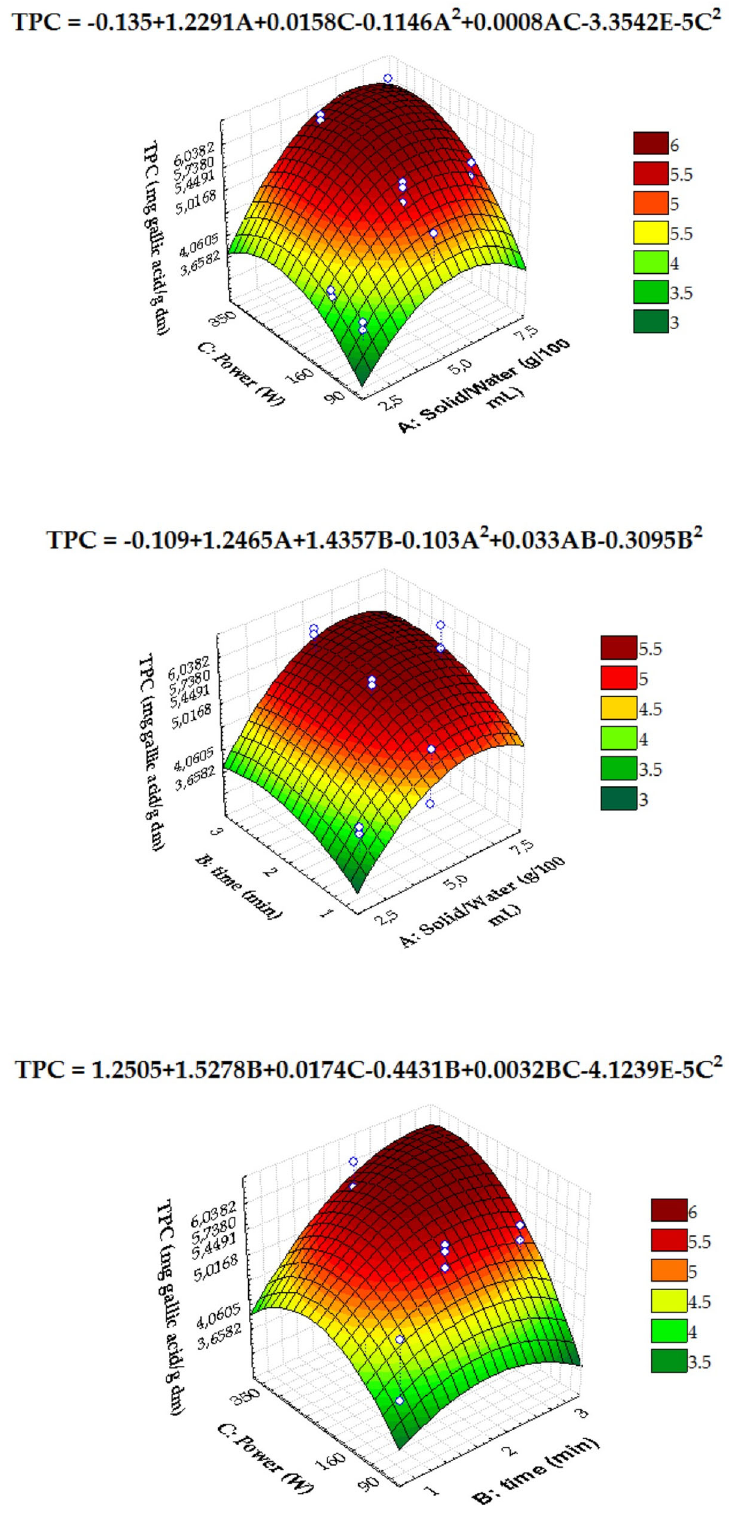
Figure 2. Three-dimensional response surface plots for TPC (mg gallic acid/g dm) of chicory extracts obtained through MAE: effect of solid–water ratio (A), extraction time (B), power (C), and their